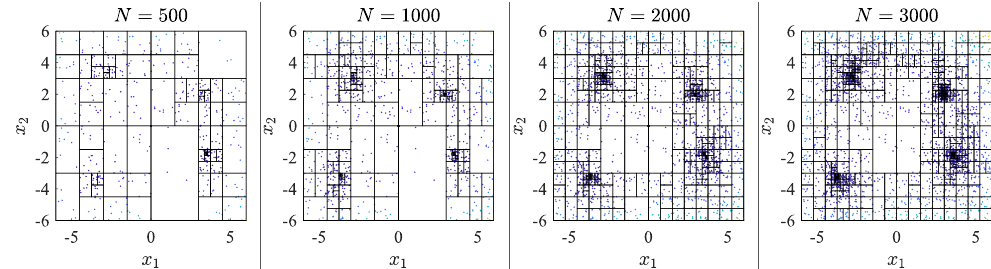
Figure 2. The partition states and the sampled solutions as the budget size N increases in the Himmelblau function minimization